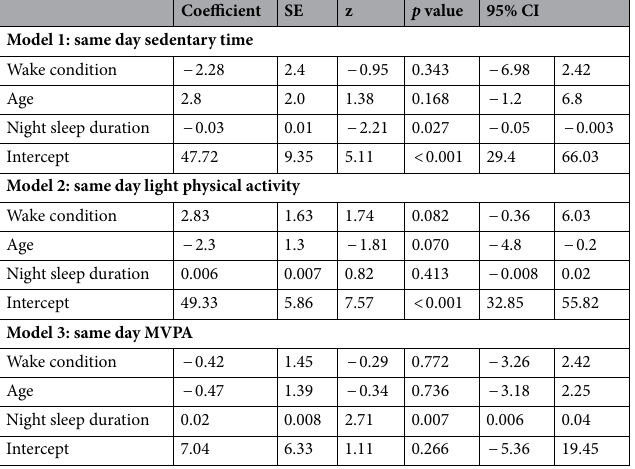
Table 3. Repeated measures mixed model results for models exploring effects of nap- and wake-promotion on same day movement behaviors. SE standard error, CI confidence interval, MVPA moderate- to vigorous- intensity physical activity.